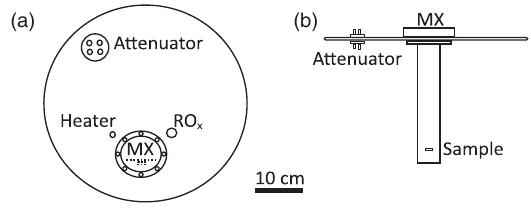
FIG. 7. Schematic representation of the base plate of the dilution refrigerator [(a) top view and (b) side view], indicating the positioning of the mixing chamber (MX), the ruthenium- oxide thermometer (RO ), the thermal anchoring point of the x attenuator, and the